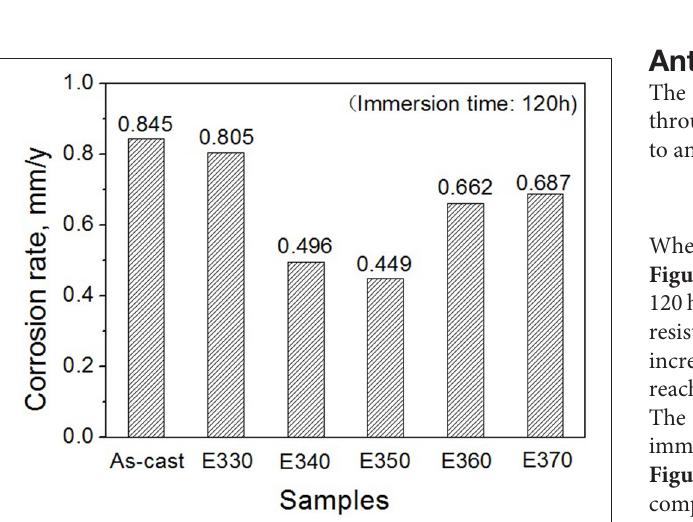
large amount of stored energy in the deformation zones (Hou et al., 2011). This means that these (Mg, Zn) 3 Gd and Mg 2 Zn 11 phase particles, with sizes far less than 1 µ m, inhibit grain boundary migration. Therefore, these fine secondary phase particles may contribute to grain refinement via grain boundary